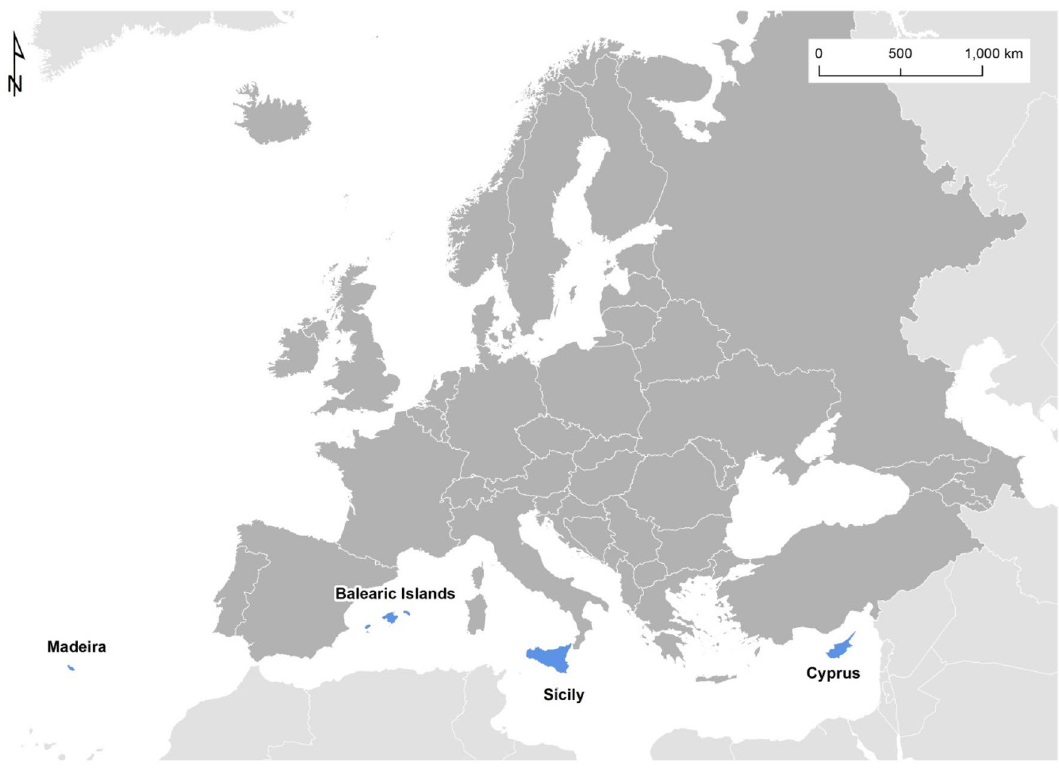
Figure 2. Location of the marinas analysed. Source : Prepared by the authors and generated with ArcMap version